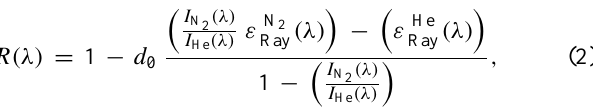
Fig. 3. (A) Emission spectra of several LEDs and a Xe arc lamp compared to mirror reflectivity. (B) Example spectra illustrate the effect of each optical filter element (cavity mirrors, GG420 cut-off filter, band-pass filter) on spectral